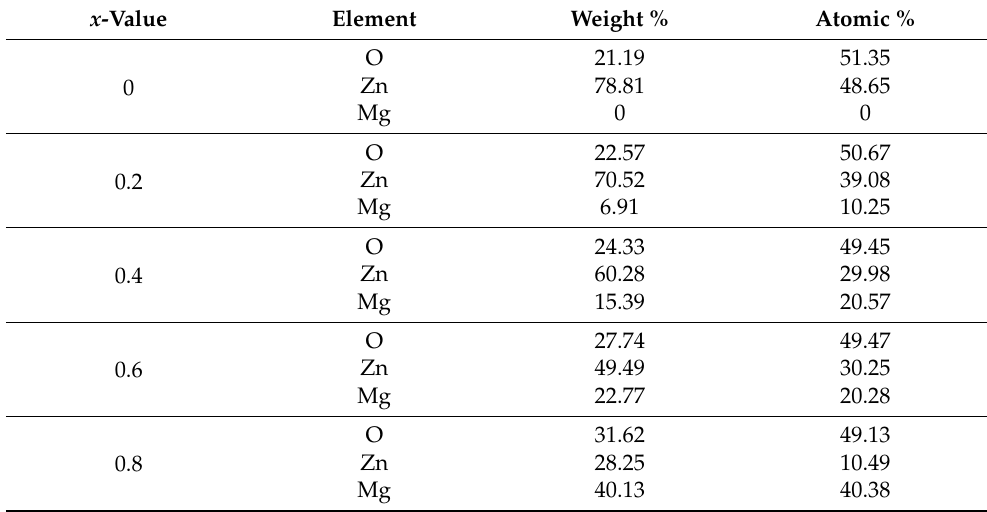
Table 2. Chemical composition, according to the EDX-analysis, of the Zn 1 − x Mg x O alloy films deposited by the aerosol spray